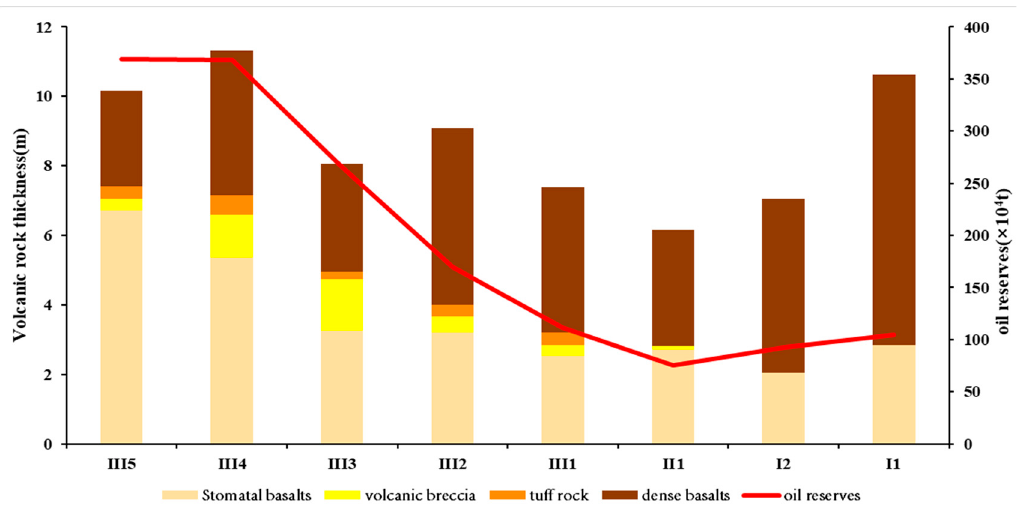
Figure 14. Distribution map of lithology and geological reserves at different stages.